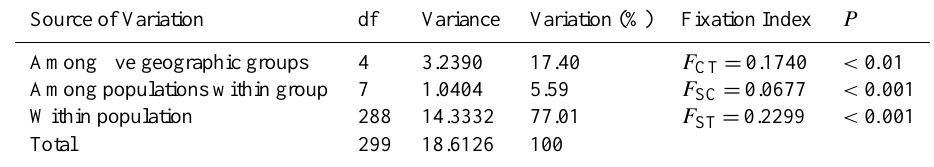
Table 5. Analysis of molecular variance (AMOVA). Populations are arranged into five groups according to location: (1) Denmark (DK and DS); (2) mainland Iceland (IG and IS); (3) Surtsey (SC, SD, SE, SF, SK); (4) Heimaey (HA and HB); and (5) Greenland (GR). Source of Variation df Variance Variation (%) Fixation Index P Among five geographic groups 4 3.2390 17.40 F CT = 0.1740 < 0 . 01 Among populations within group 7 1.0404 5.59 F SC = 0.0677 < 0 . 001 Within population 288 14.3332 77.01 F ST = 0.2299 < 0 . 001 Total 299 18.6126